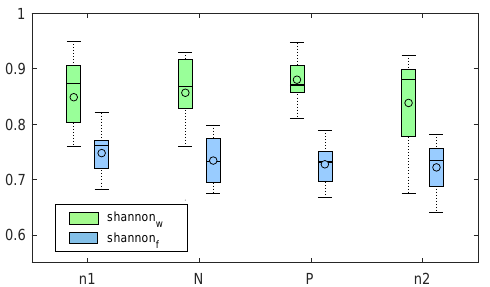
Figure 2. evBoxplots related to shannon f (blue) and shannon w (green) values corresponding to the four experimental sessions (n1, N, P,